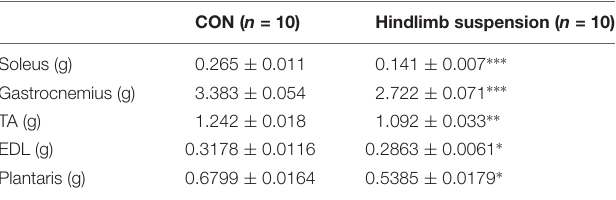
TABLE 3 | Skeletal muscles weight following hindlimb